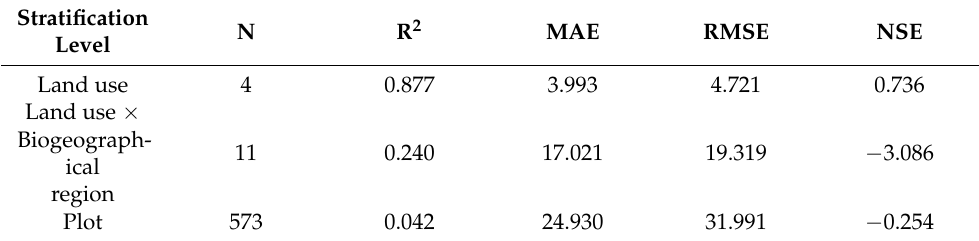
Table 4. Summary of model evaluation regarding different